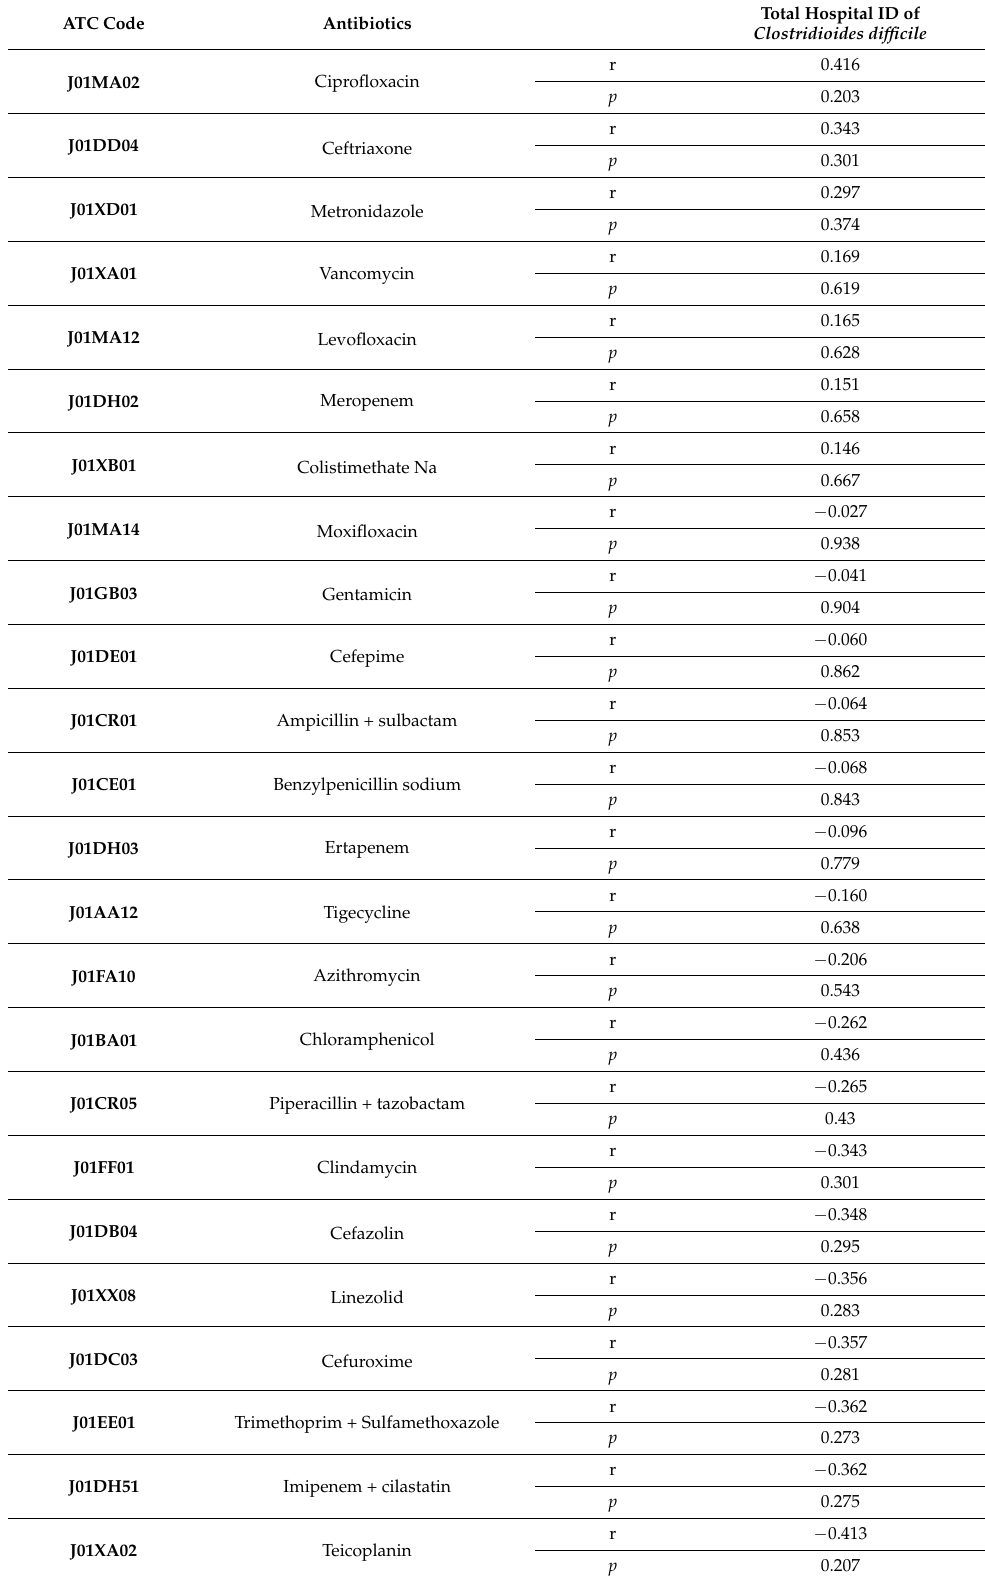
Table 3. Correlation between consumption of particular antibiotics and incidence density (ID) of Clostridioides difficile infection in the tertiary university hospital in Serbia,